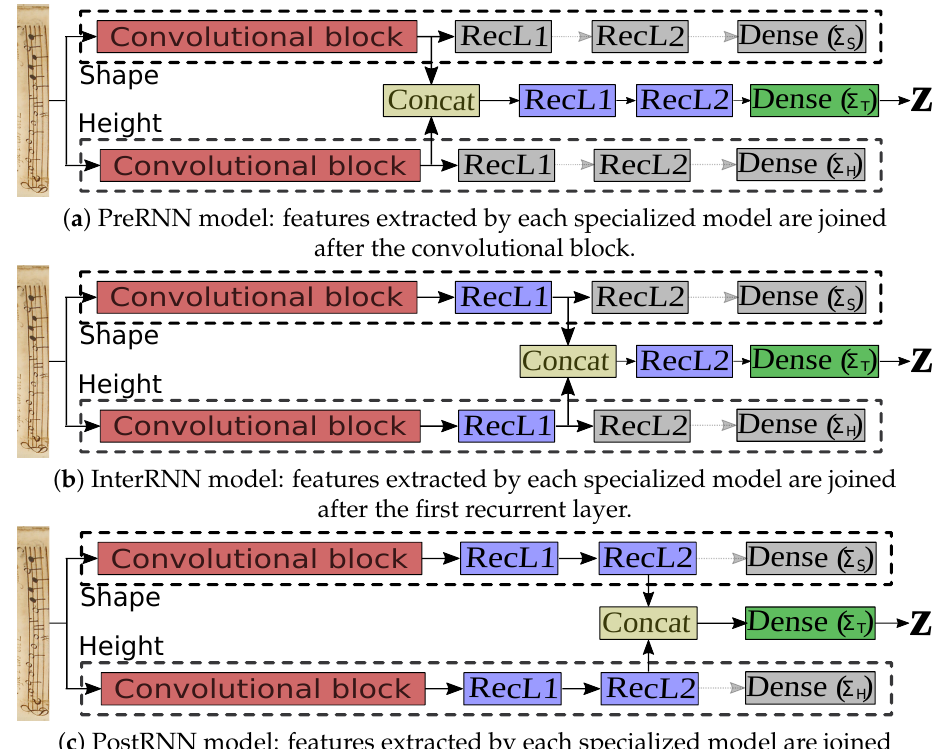
Figure 3. Graphicaldescription of the three CRNN-based architectures proposed. The Concat block concatenates the input features from each branch. Gray layers represent the ones that are only considered during the training stage of the